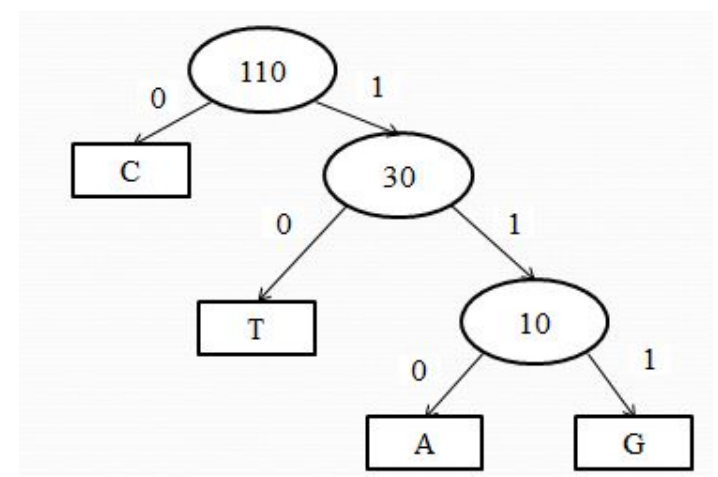
Figure 4: Generated tree for Example